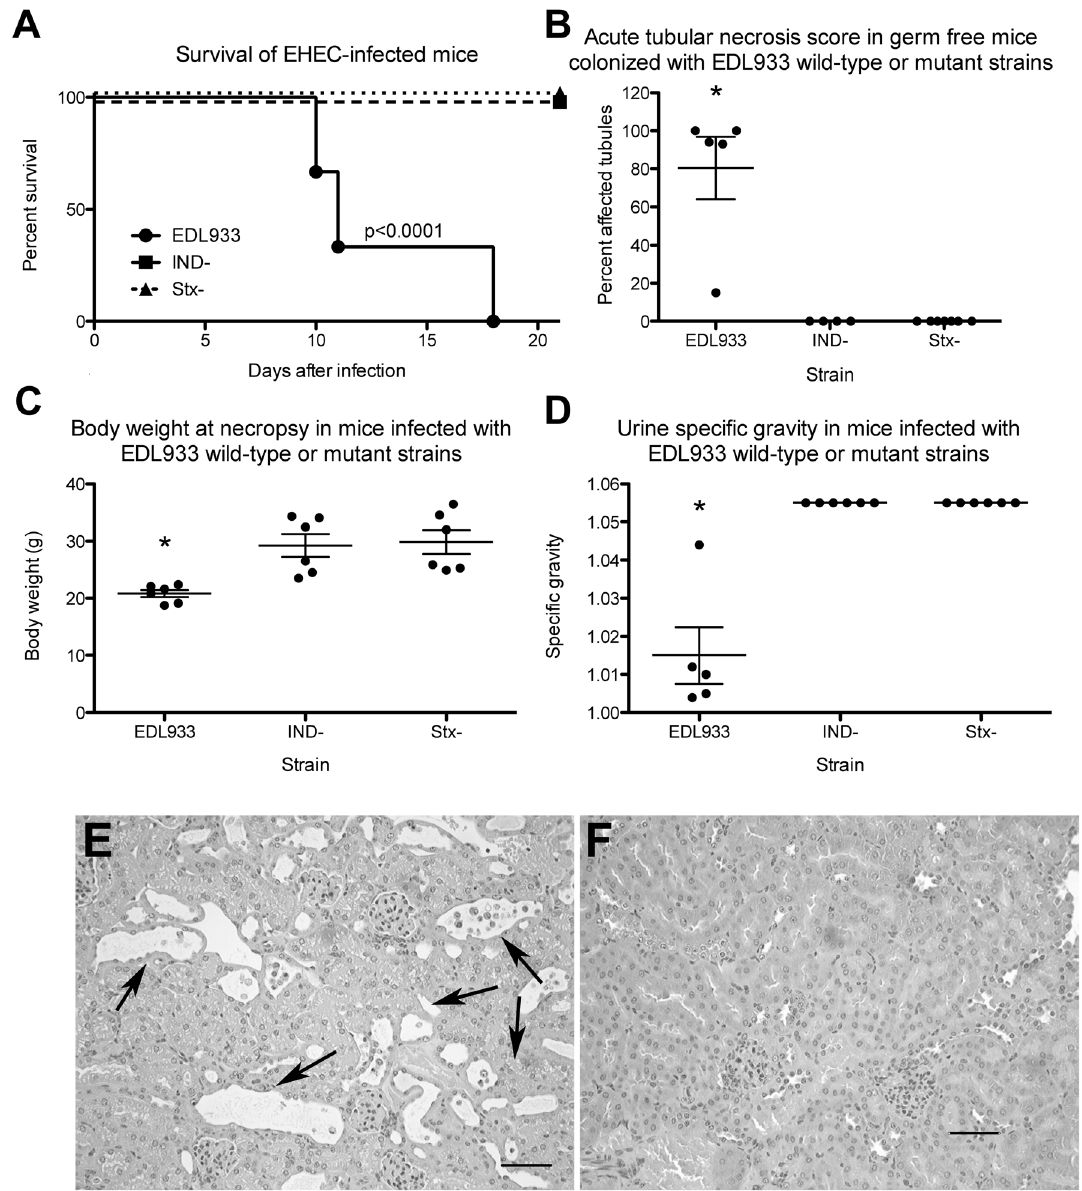
Figure 4. Disease in mice infected with EDL933. A: Kaplan-Meier survival curve; B: Acute tubular necrosis score; C: Body weight at necropsy; D: Urine specific gravity; E: Hematoxylin and Eosin stained section of kidney from a mouse inoculated with EDL933. Many tubules are necrotic and contain cellular debris (arrows). A few glomeruli contain fibrin thrombi (arrowheads). F. Mouse infected with the EDL933 cIind1 negative mutant. Tubules and glomeruli are normal. Bars=50 microns. * Significantly different from mice infected with Ind- or Stx- mutants, p , 0.001. Slides were scored blind without knowledge of their source. Animals were euthanized and tissues removed for examination; at 10 days post infection with EDL933 (day at which they became moribund) and at 21 days post infection with EDL933 cIind1I (did not become